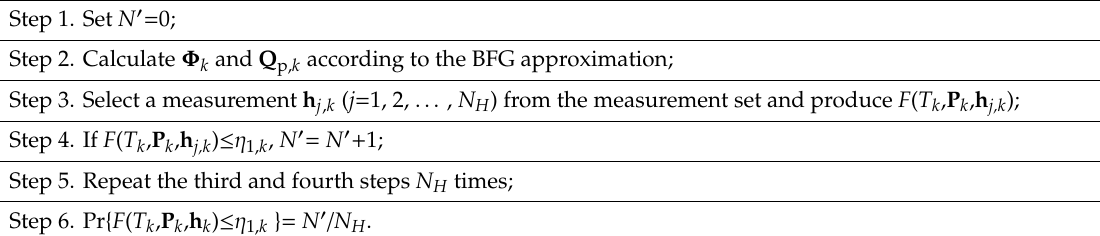
Table 1. The stochastic simulation.